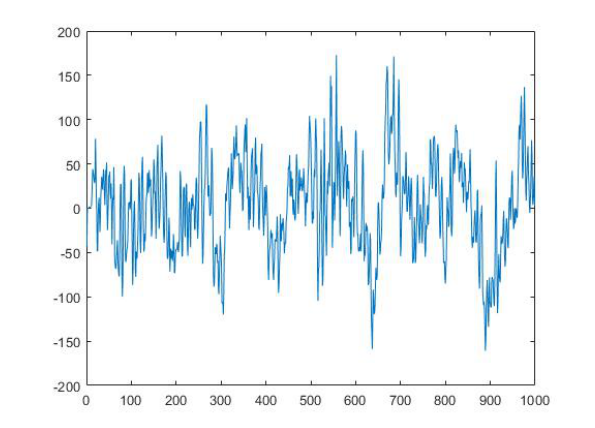
Figure 18. chb05-03 OWA Output